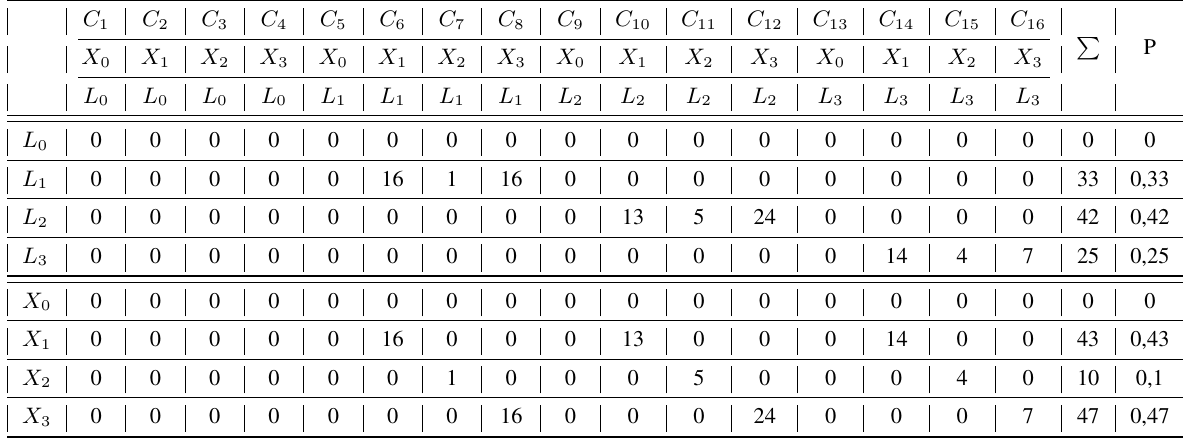
Table 4: Calculation of the border numbers of all L and X .